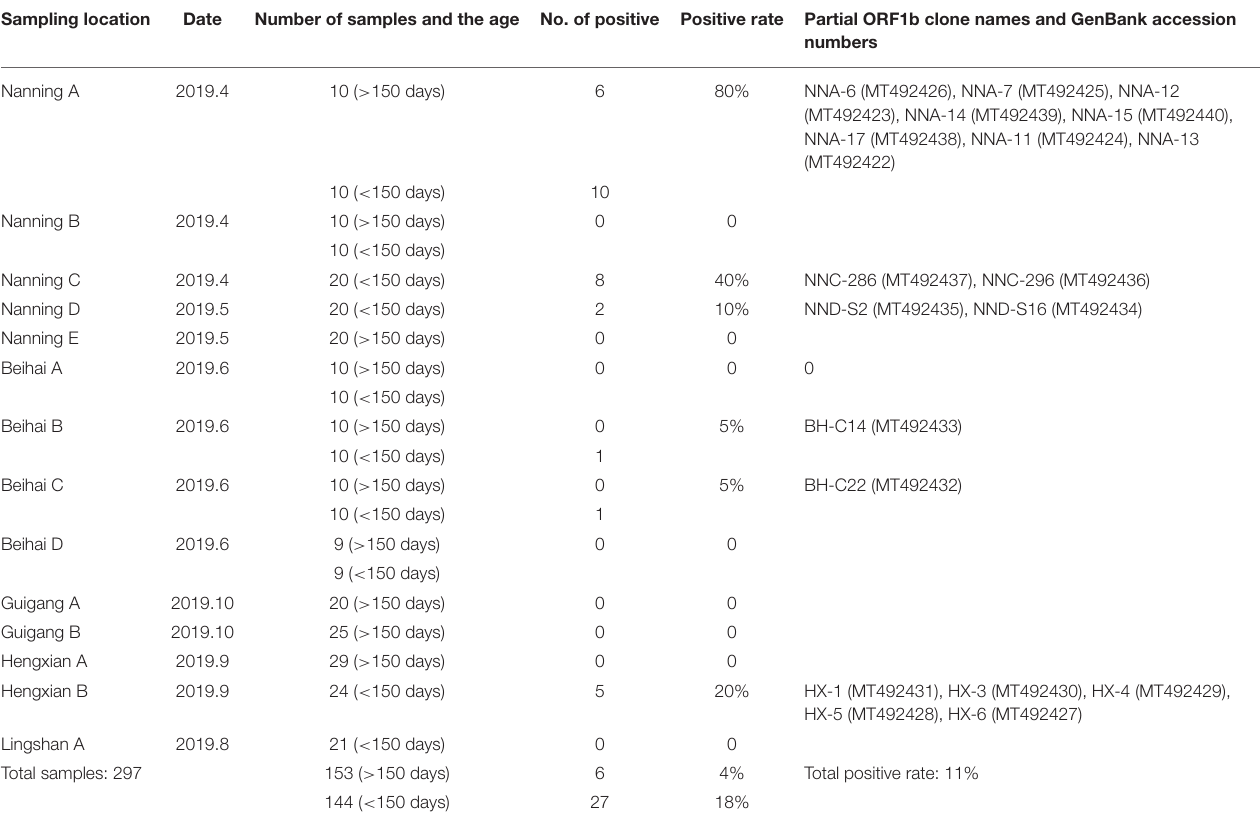
TABLE 1 | Details of sample information and